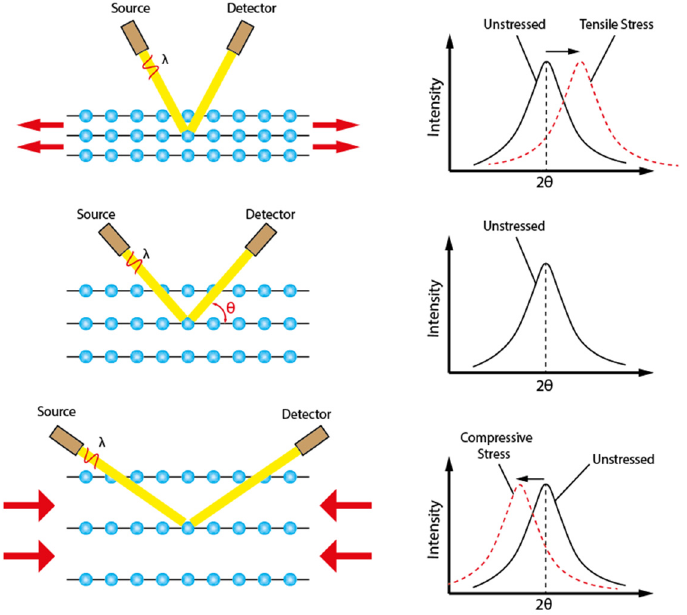
Figure 2. X-ray intensity peak shift with tensile and compressive stress.